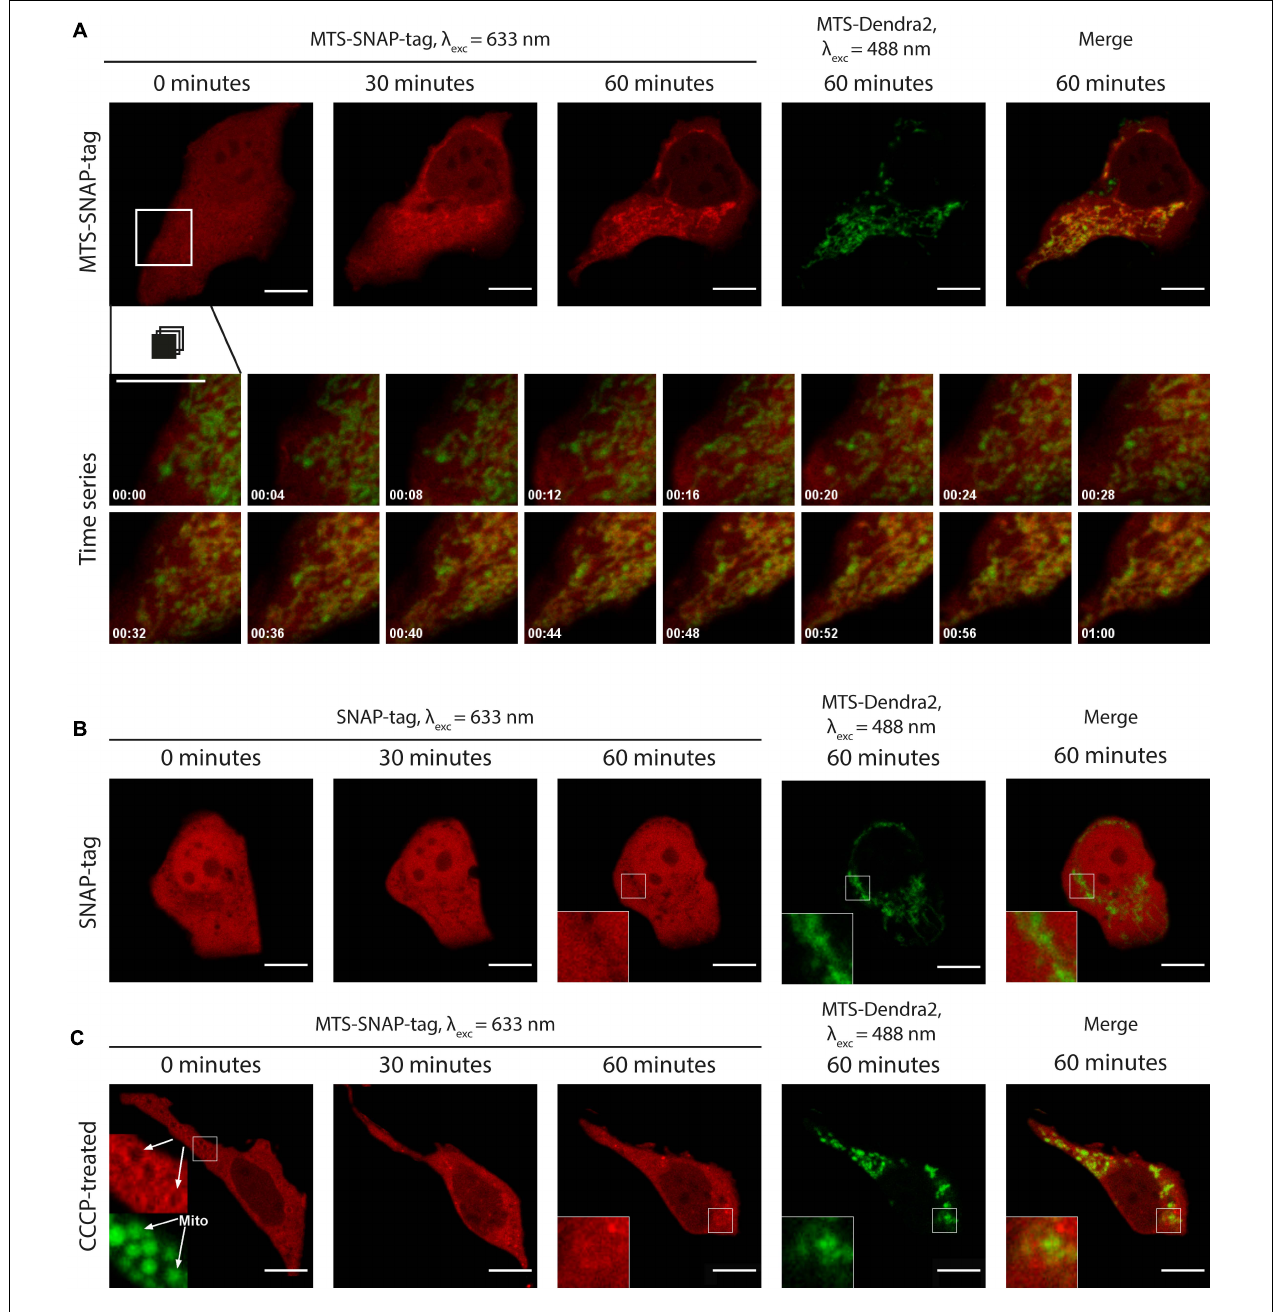
FIGURE 3 | (A) Time-lapse microscopy of MTS-SNAP-tag protein redistribution in HEK293-MTS-Dendra2 cells after the injection. The MTS-SNAP-tag protein fluorescence (red) co-localizes with the mitochondria after 30 min. The mitochondria are labeled by the MTS-Dendra2 protein (green). The bottom row shows a time series of the selected region. The tracking time is given in minutes. (B) Time-lapse microscopy of the SNAP-tag protein redistribution (red) in the HEK293-MTS-Dendra2 cells after the injection, the “shadows” correspond to the mitochondria, as seen in the enlarged inset by comparison with the MTS-Dendra2 labeled mitochondria (green). (C) Time-lapse microscopy of the MTS-SNAP-tag protein redistribution after the injection in the HEK293-MTS-Dendra2 pre-incubated with 50 µ M CCCP. The MTS-SNAP-tag protein (red) initially forms a brighter rim around the spherical mitochondria (green), indicated by white arrows in the enlarged insets in the first image (0 min). Scale bars: 10 µ